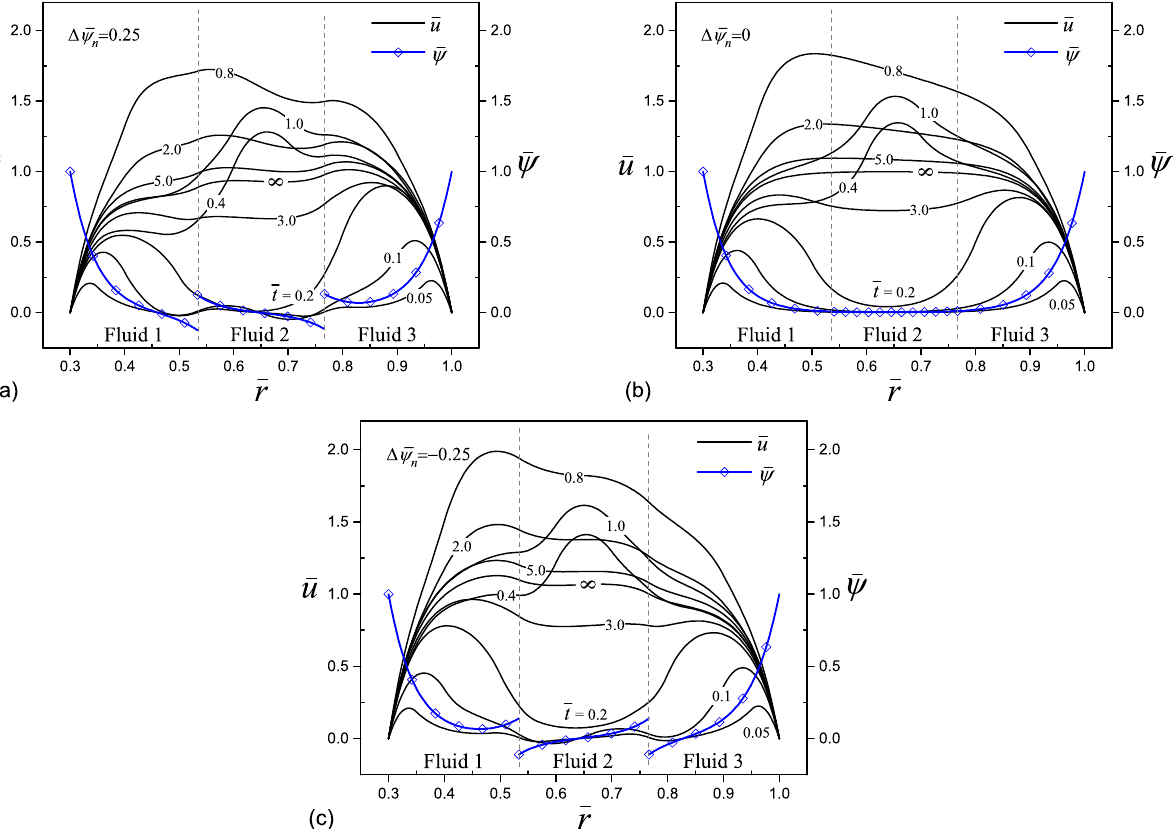
Figure 3. Dimensionless electric potential and velocity profiles of a purely electro-osmotic flow with n = 3, a = 0.3, Γ = 0, ¯ κ n = 20, ¯ ρ n = ¯ η n = ¯ (cid:101) n = ¯ λ n = ¯ ζ I,O = 1, ¯ r 1 = 0.533 and ¯ r 2 = 0.766, for ( a ) ∆ ¯ ψ n = 0.25, ( b ) ∆ ¯ ψ n = 0, and ( c ) ∆ ¯ ψ n = −